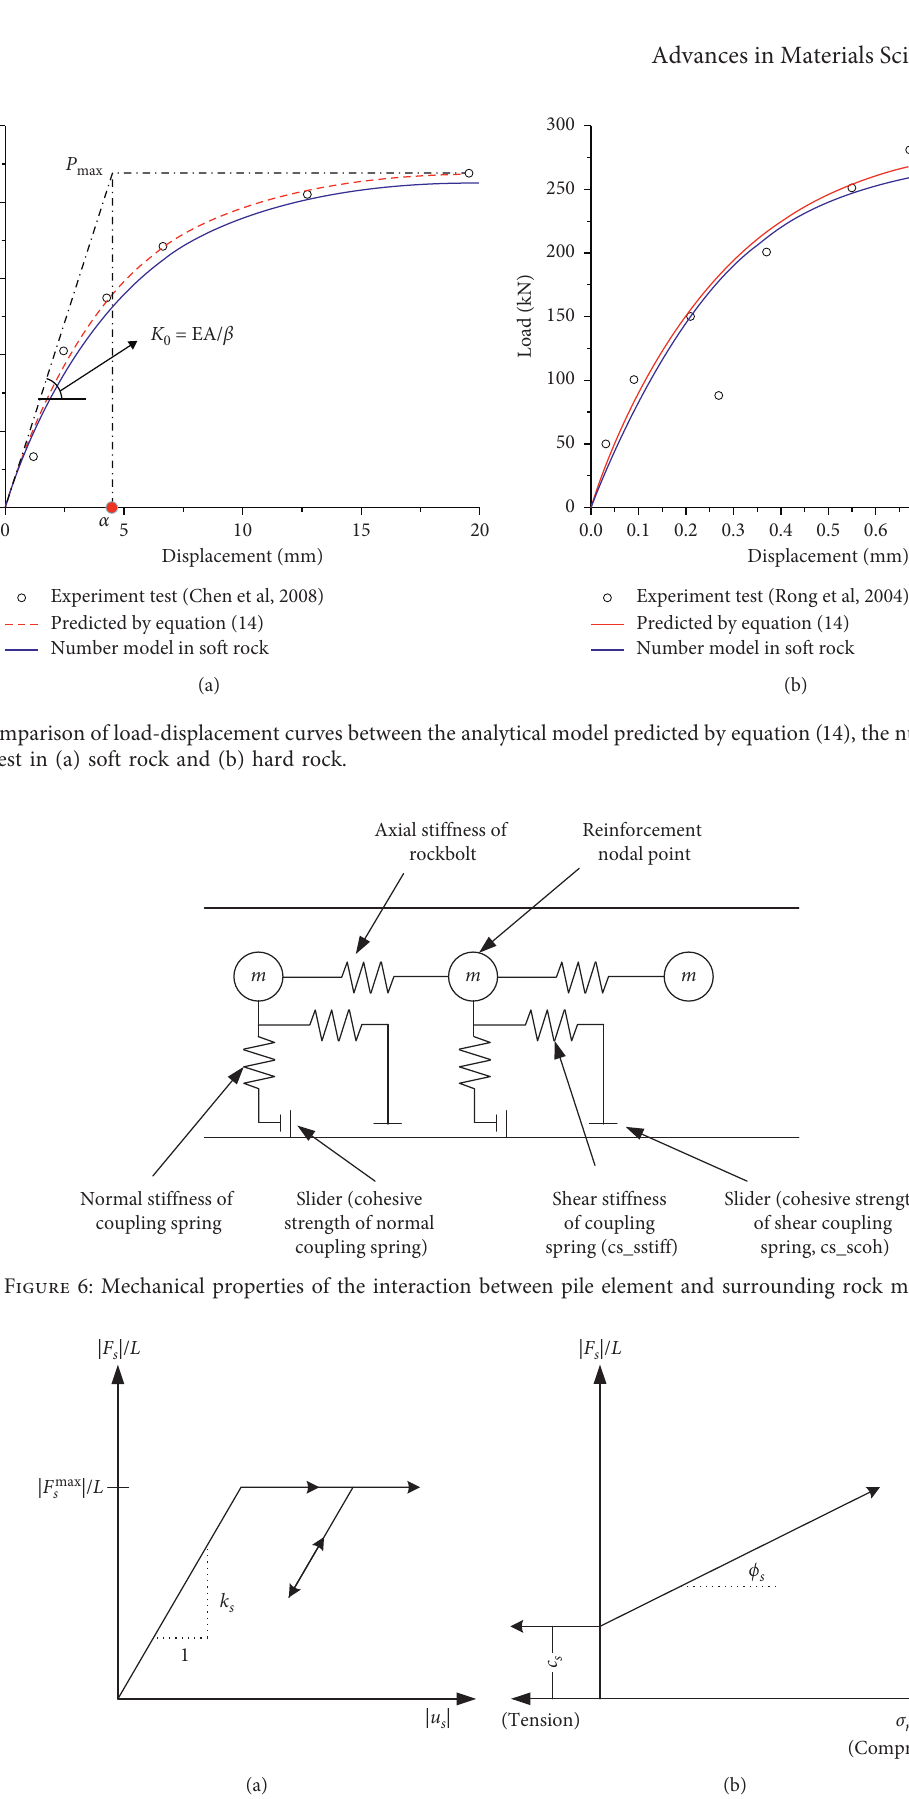
Figure 7: Behavior of shear coupling springs of pile element [38]. (a) Shear force/length versus relative shear displacement u strength